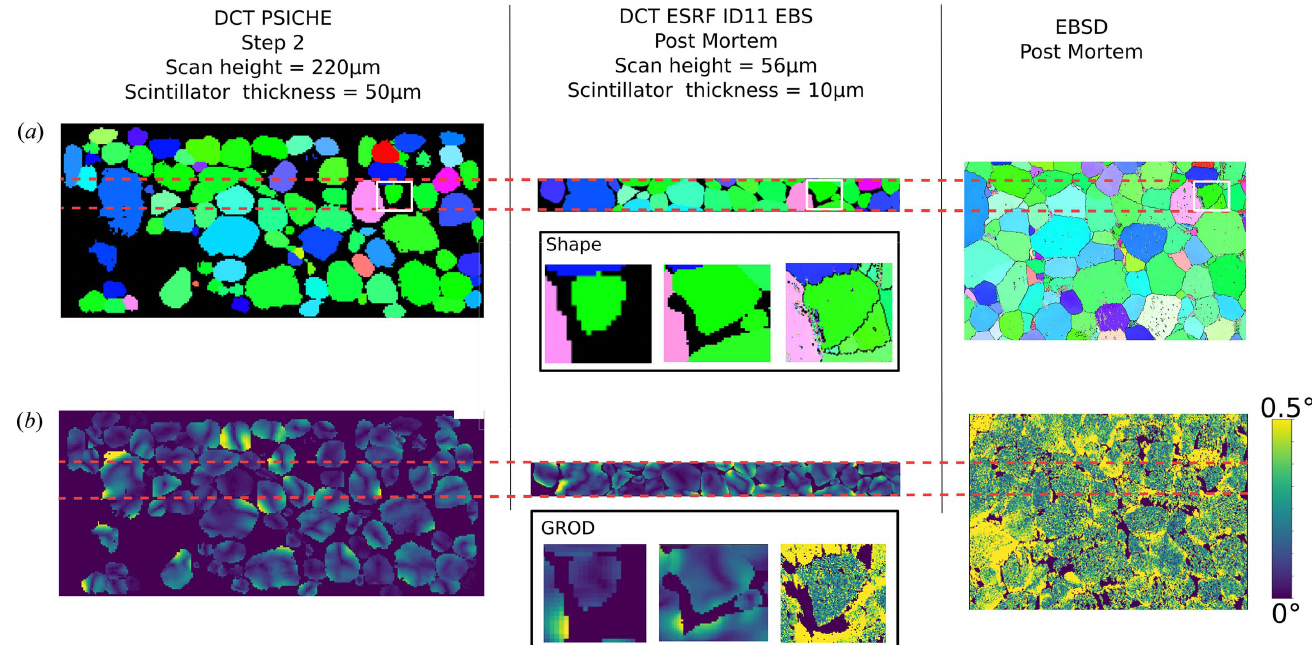
Figure 9 Comparison of the DCT performance between Psiche´ acquisition and the reference ESRF ID11 in the deformed state: ( a ) IPF-Z view of registered slices with EBSD, ( b ) GROD fields for each acquisition; insets show a zoomed-in view of a grain of